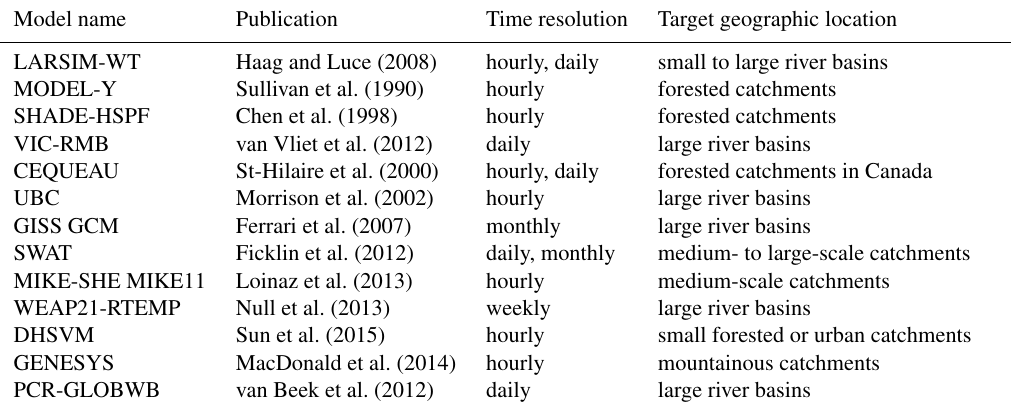
Table 1. List of semi-distributed hydrological models which simulate both stream discharge and stream temperature and have been reviewed in the context of the present